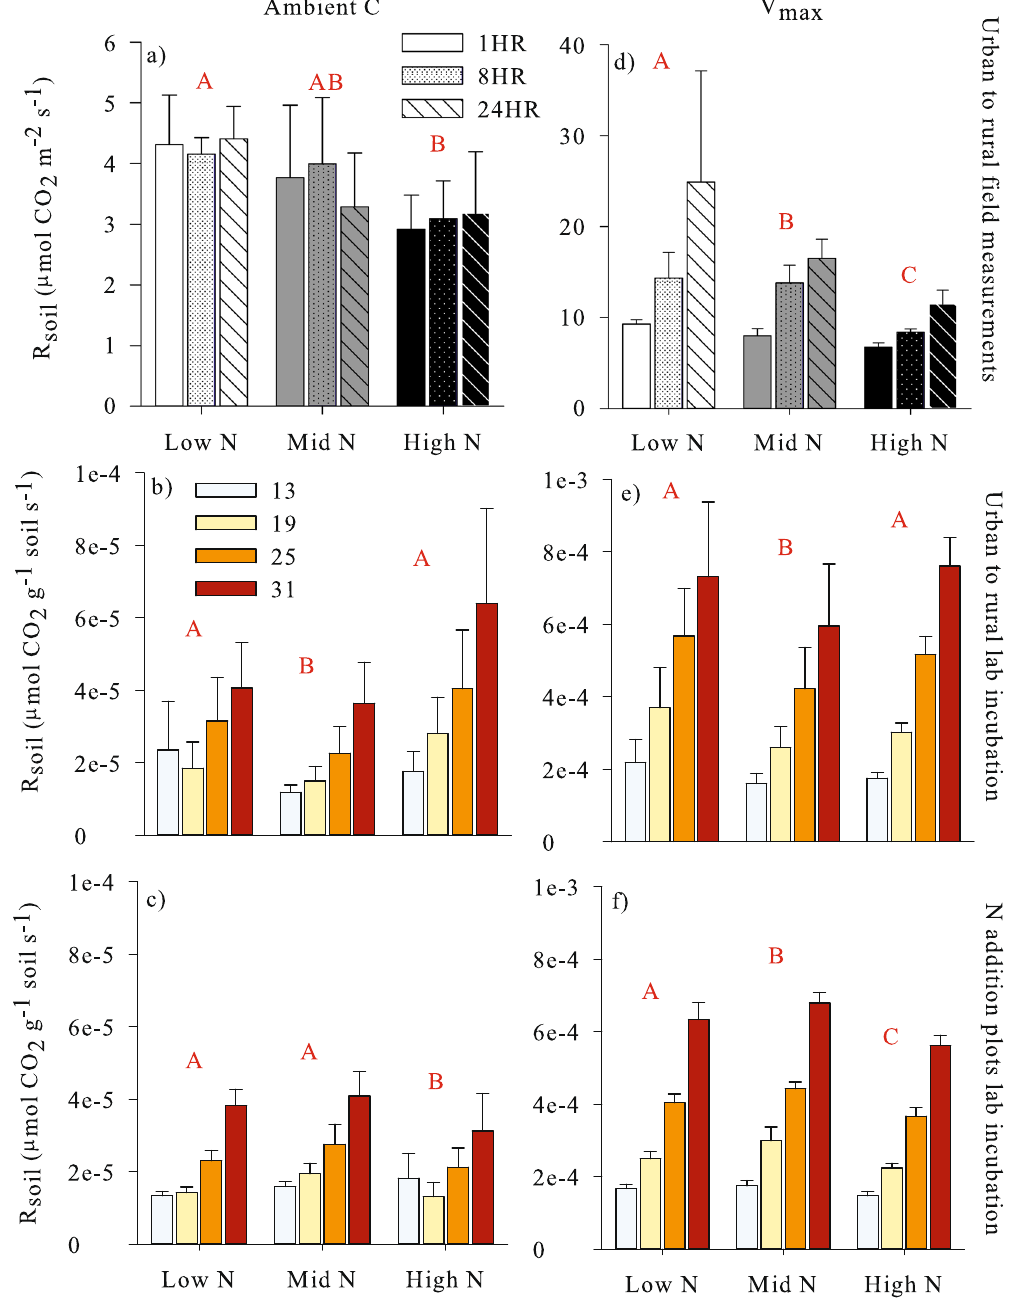
Figure 2. Soil CO 2 production (R soil ) for ambient soil carbon ( a – c ) compared to saturating carbon (V max ; ( d – f )) for the field measurements along the urban to rural transect ( a , d ), the laboratory incubation of soils from the urban to rural transect ( b , e ), and the laboratory incubation of soils from the nitrogen addition plots. Legends indicate time since treatment addition ( a , d ) or temperature in °C ( b , c , e , f ). Error bars represent standard deviation. Letters represent significance at p < 0.05 from mixed-linear model followed by Holms-corrected Tukey Contrasts for a and d (n = 4) and 2-way ANOVA followed by Tukey HSD for ( b , e ) (n = 5) and ( c , f ) (n =